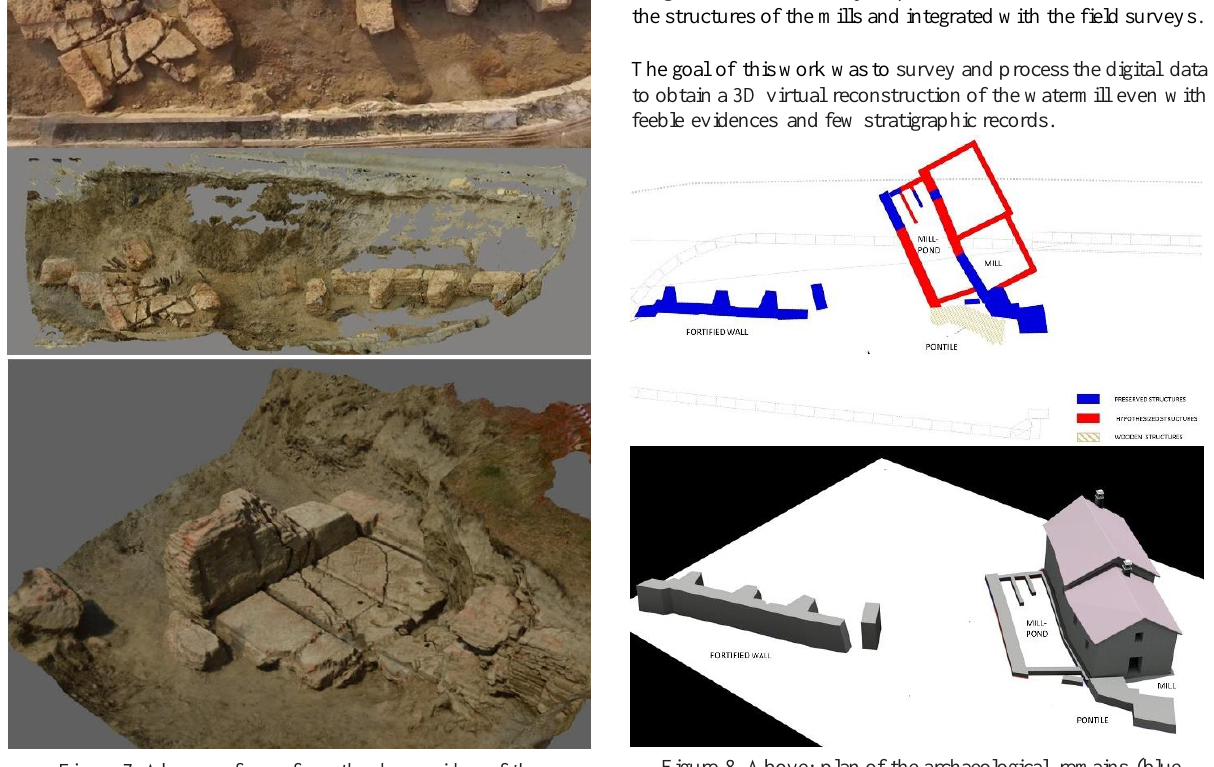
Figure 7. Above: a frame from the drone video of the archaeological structures and the 3D model of the fortified wall and part of the watermill. Below: detail of reality-based 3D model of the channels from close range photogrammetry.